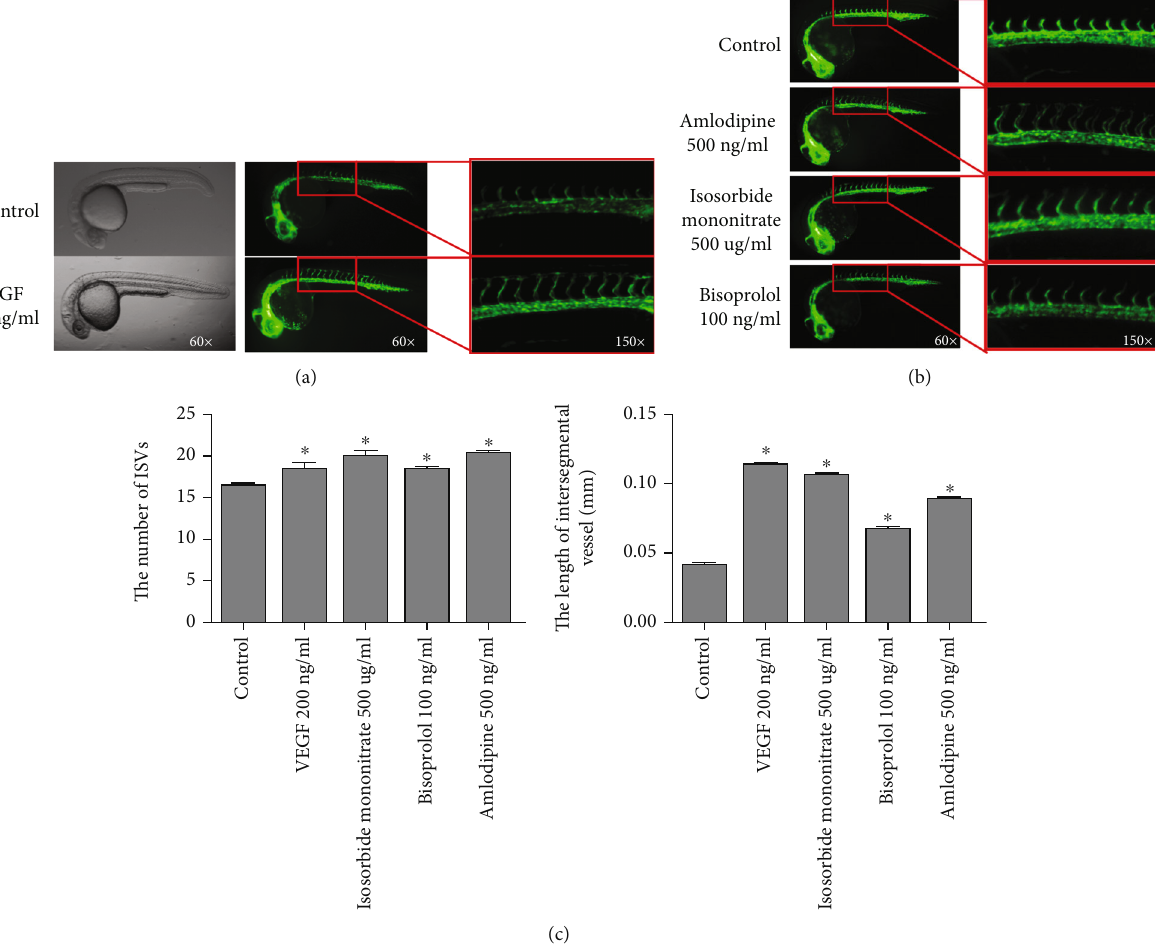
Figure 2: Chemical screen to identify angiogenic drugs in cardiovascular medicine. (a) Bright- fi eld and fl uorescent images of zebra fi sh embryos in 24 hpf treated with 0.5% DMSO (control) and 200 ng/ml VEGF (positive control) for 24h. (b) Amlodipine-, isosorbide mononitrate-, and bisoprolol-treated embryos are shown. (c) Average ISV numbers and lengths in the control and drug-treated zebra fi sh embryos. Values for the average ISV numbers and lengths are present as mean ± SD . ∗ P < 0 : 05 vs. control